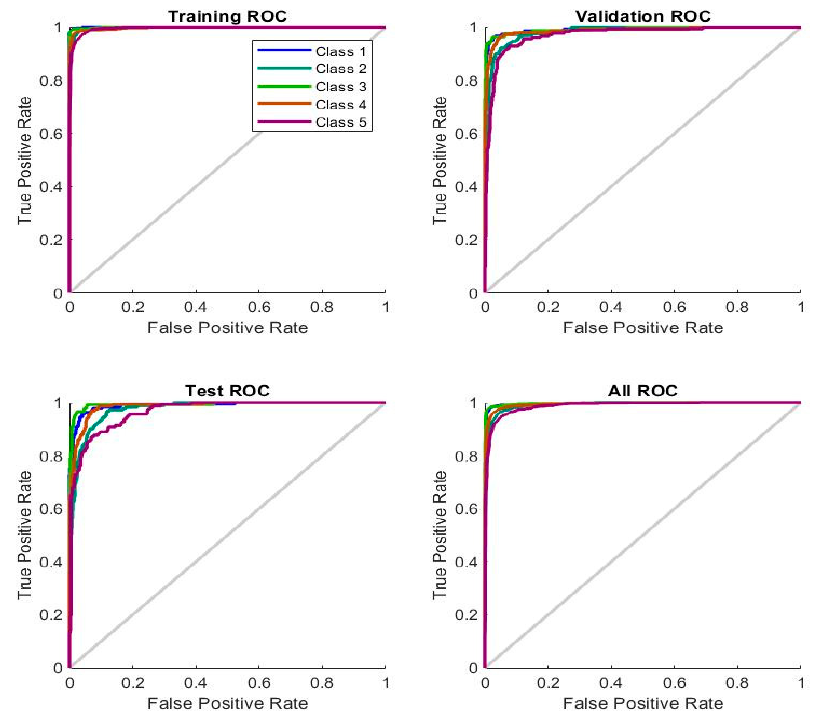
Figure 13. Displays the performance of ANN through ROC for endoscopic image